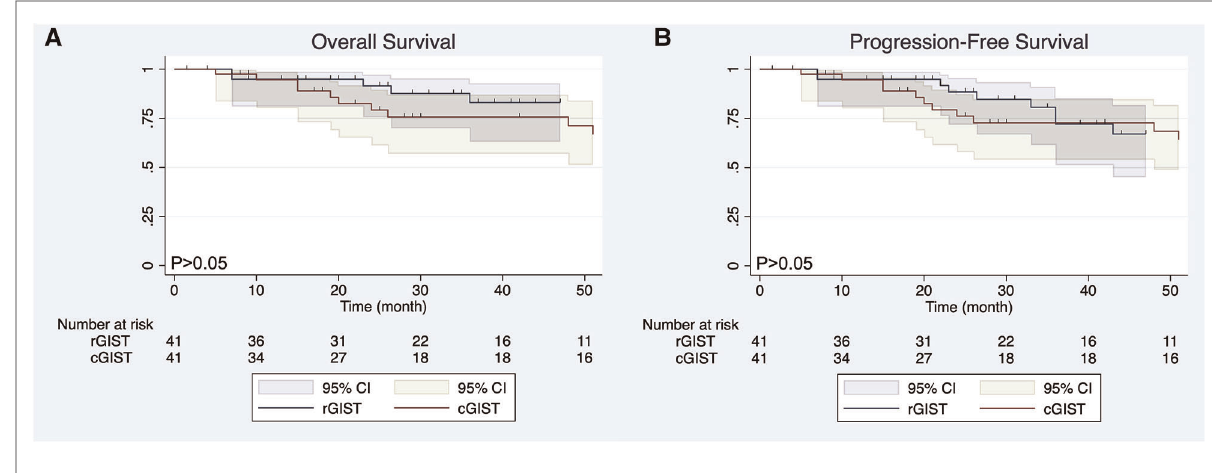
FIGURE 3 Overall survival ( A ) and progression-free survival ( B ) of cGIST and rGIST after propensity score